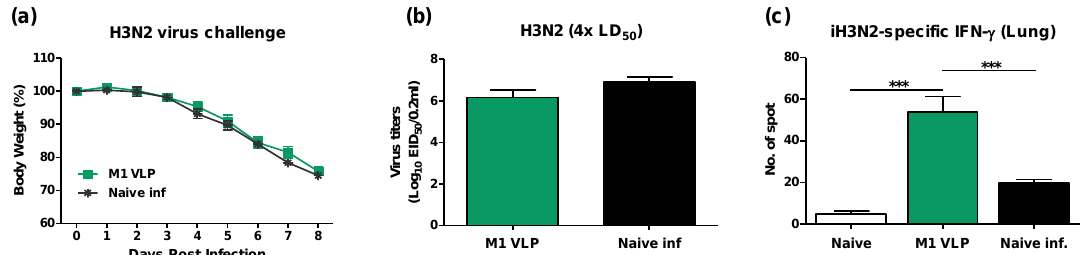
Supplementary Figure 2. Anti-M2e antibody responses in immune sera collected before challenges. M2e-specific antibody responses were determined in boost immune sera collected at 10 weeks after immunization by ELISA. IgG (a), IgG1 (b), and IgG2a (c) in immune sera. V: 5xM2e VLP, P: 5xM2e protein, V-P: VLP prime/protein boost, P-V: protein prime/VLP boost, P-P: protein prime boost, V-V: VLP prime boost.